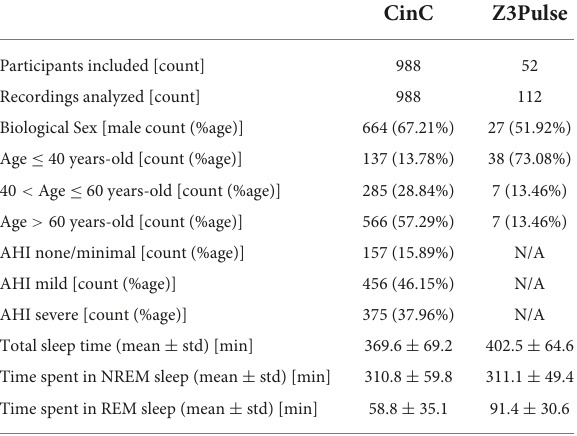
TABLE 1 Summary characteristics of the participants included in CinC and Z3Pulse